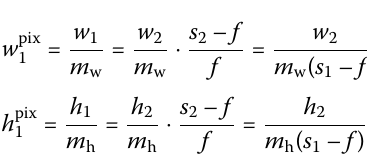
one pixel are given